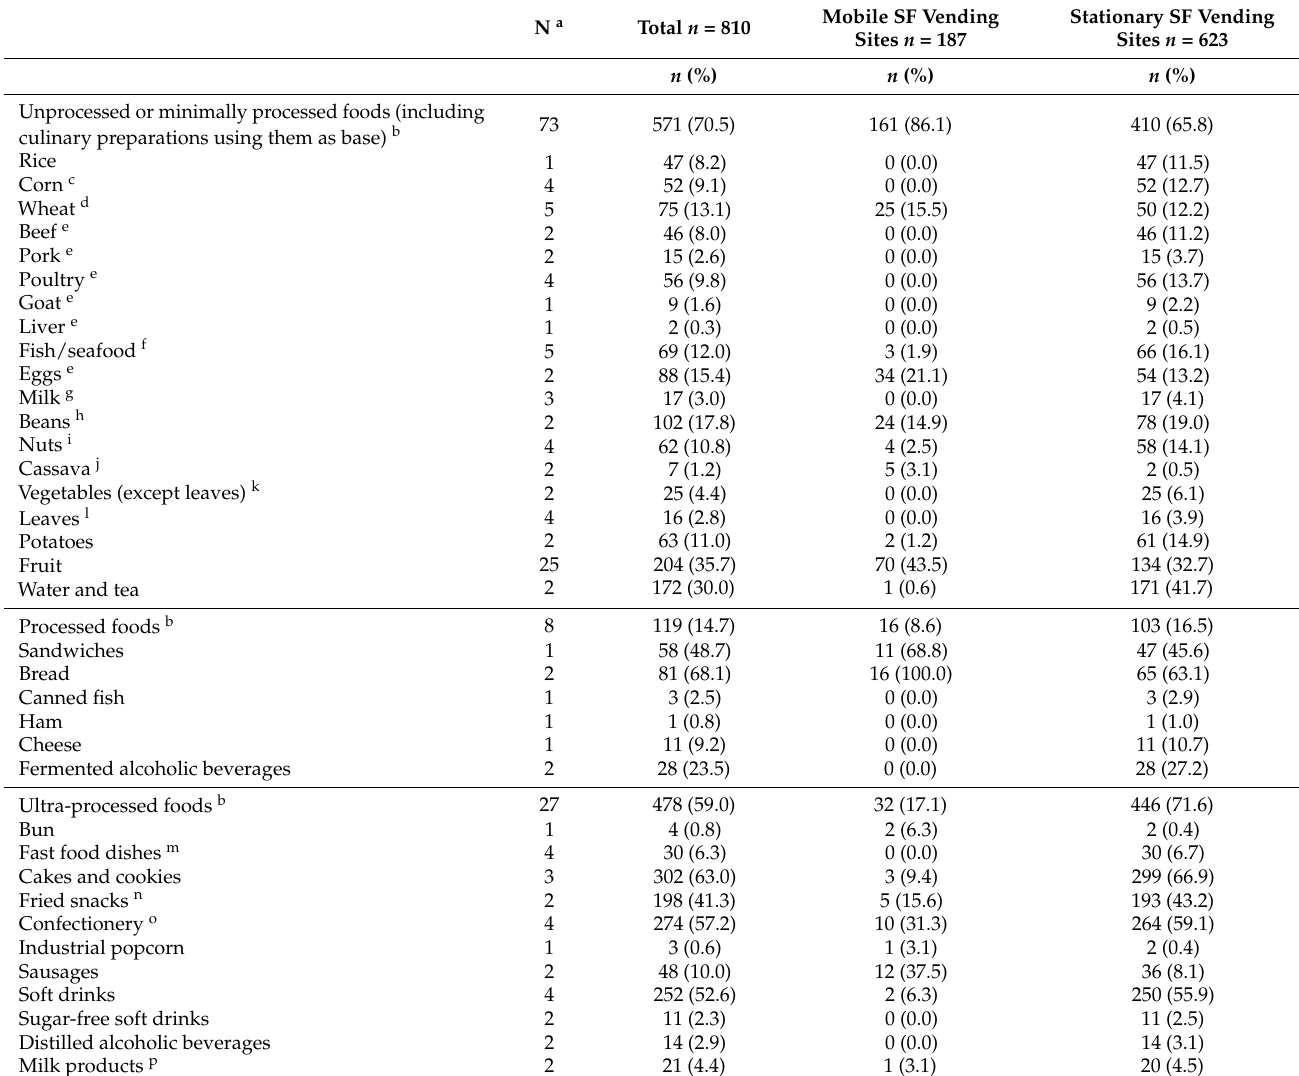
Table 1. Ready-to-eat foods and beverages available in mobile and stationary street food vending sites in KaMpfumu, Maputo, Mozambique, according to degree of processing ( n = 810, available for